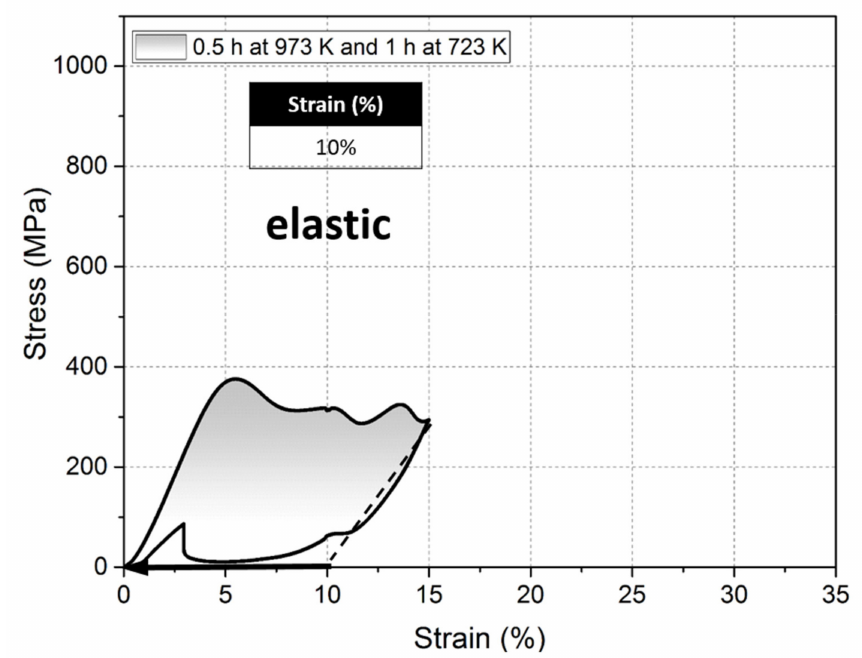
Figure 6. Superelastic response of the [001] oriented FeNiCoAlTa single crystal aged at 973 K for 0.5 h and 723 K for 1 h under compression at 77 K (second